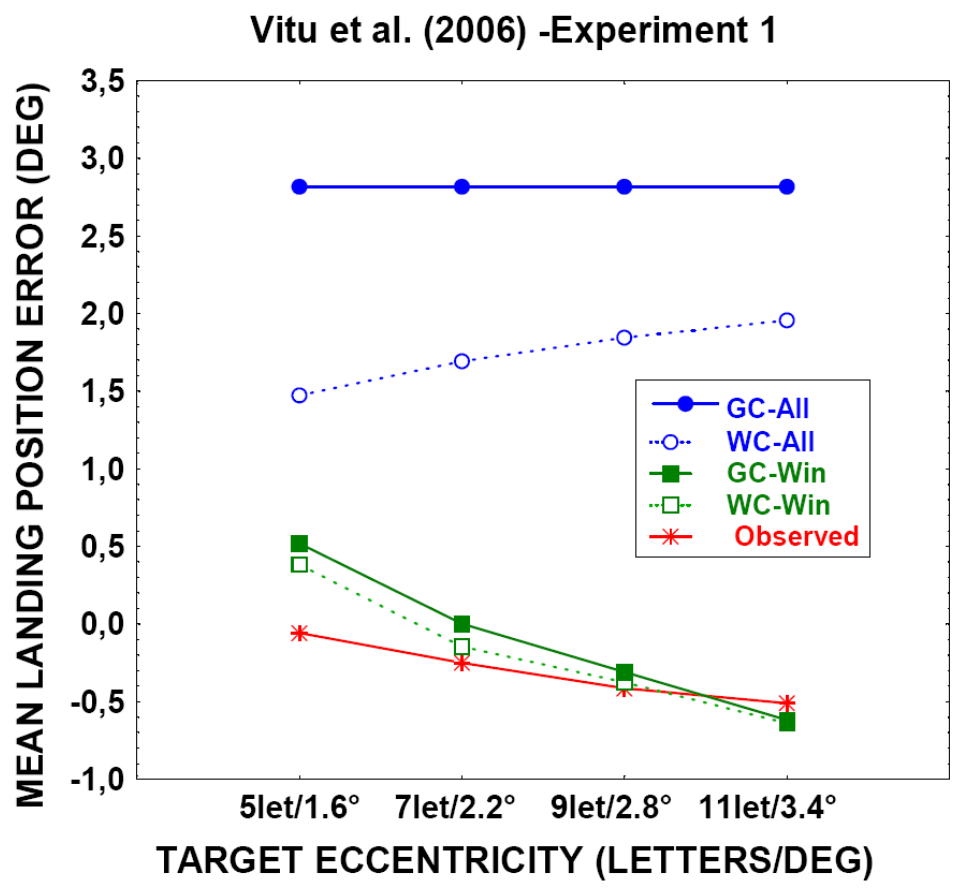
Figure 7. The observed and predicted mean landing position error of the initial saccade as a function of the eccentricity of the target letter (5-11 letters or 1.6-3.4°) in Vitu et al.’s (2006) Experiment 1; the target letter was embedded in a 7-letter string presented simultaneously with a single distractor letter at fixation, and two peripheral letter strings (of 7 and 9 letters respectively) to its right. Predictions were derived from alternative versions of the centre-of-gravity assumption: the geometrical and the cortically-weighted centre of gravity of the full configuration (including all stimuli to the right of the fixation point; GC-all and WC-all respectively), and the geometrical and the cortically-weighted centre of gravity of a peripheral window of 2.4° from the end of the foveal dead zone (or 1.1° from the fixation point; GC-win and WC-win respectively). The angular position of the cortically-weighted centre of gravity (CW) was calculated using the same formula as in Figure